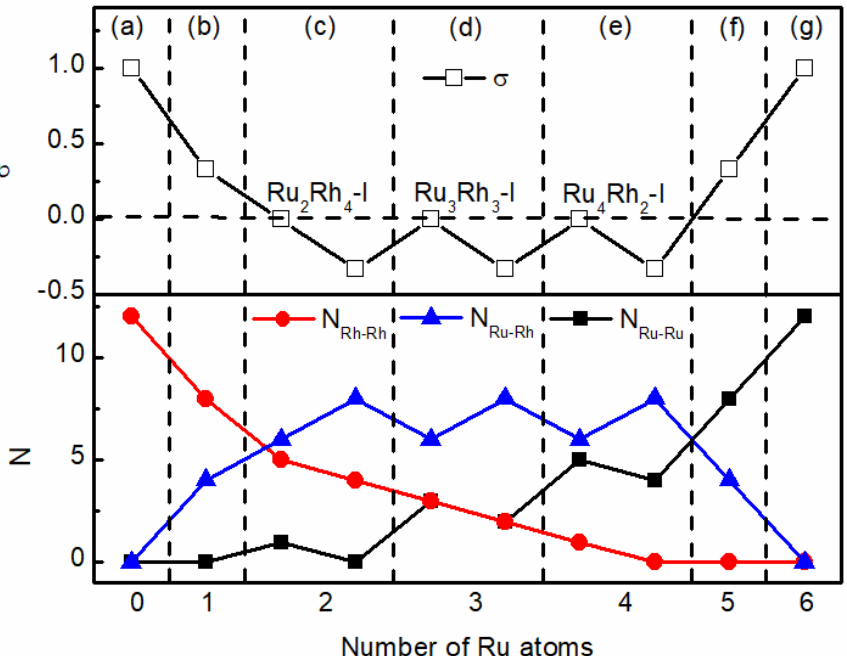
Figure 2. Bond order parameters σ and number N of Ru − Ru bonds, Rh − Rh bonds and Ru − Rh bonds of octahedral Ru m Rh n clusters varying with the number of Ru atoms. (a) Ru 6 , (b) Ru 1 Rh 5 , (c) Ru 2 Rh 4 , Ru 2 Rh 4 -I, (d) Ru 3 Rh 3 , Ru 3 Rh 3 -I, (e) Ru 4 Rh 2 , Ru 4 Rh 2 -I, (f) Ru 5 Rh 1 and (g) Rh 6 . Ru 2 Rh 4 , Ru 3 Rh 3 , and Ru 4 Rh 2 are mixed or alloyed clusters.